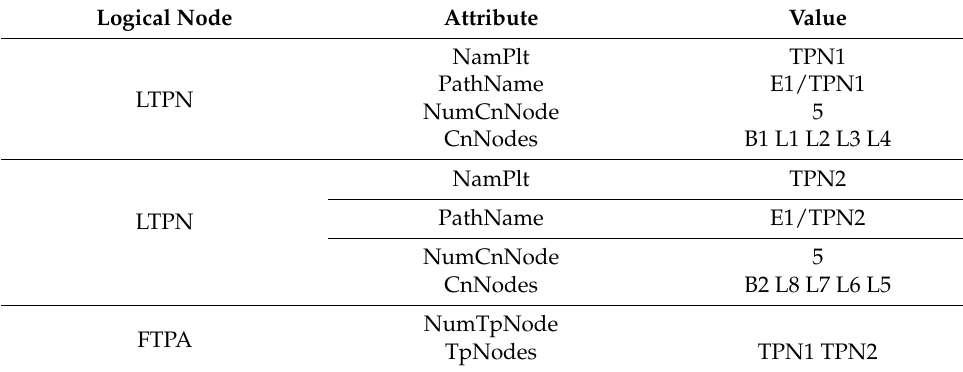
Table 6. Logical nodes LTPN and